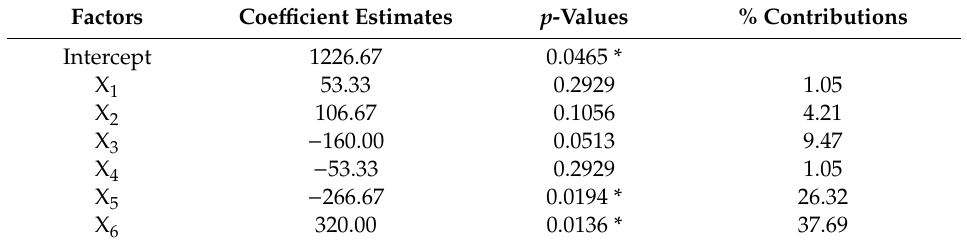
Table 5. Partial regression coe ffi cients and analyses of their